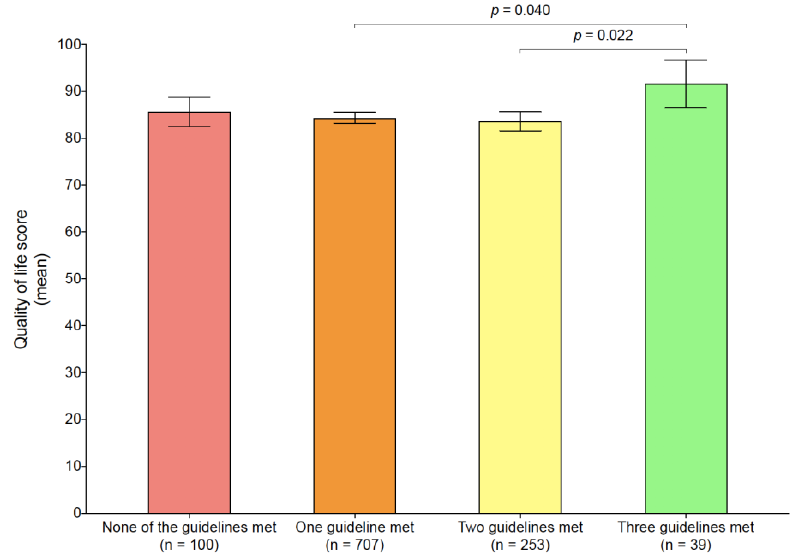
Figure 2. Mean differences in the HRQoL scale according to the meeting of different 24 h movement guidelines. Adjusted for age, sex, nationality, breadwinner’s educational level, socioeconomic status, body mass index (z-score), and Mediterranean diet.